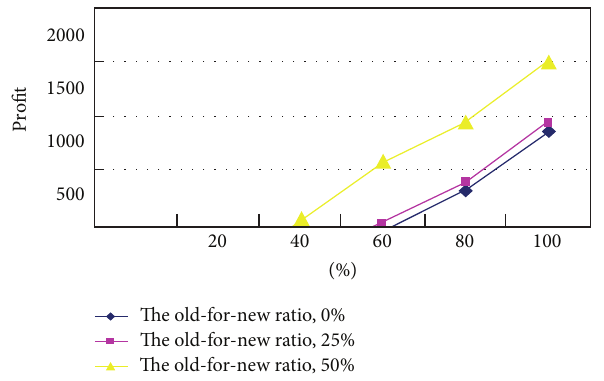
Figure 6: The old-for-new policy has impact on the